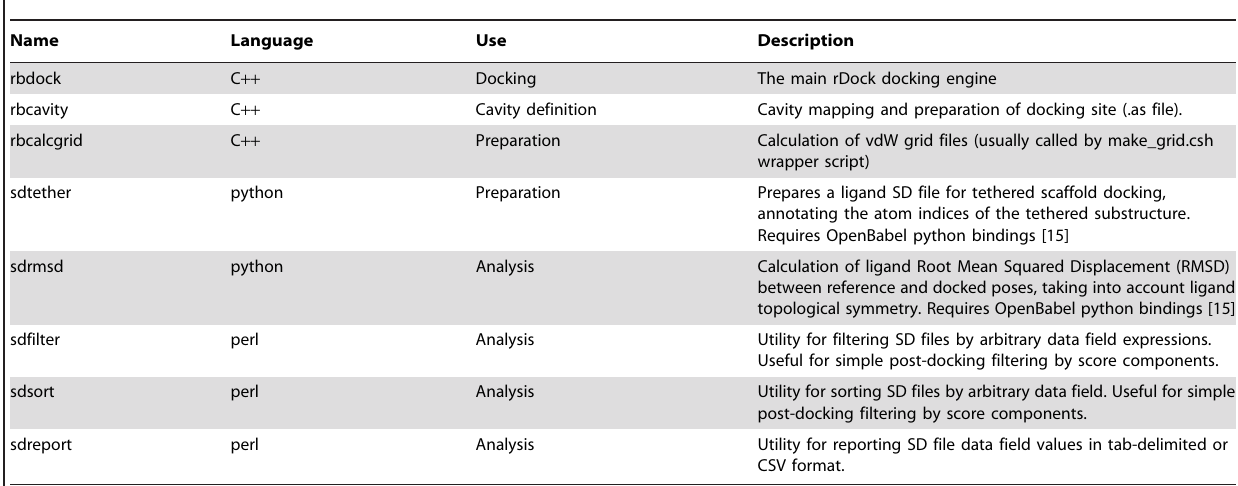
Table 1. List of main programs and utilities included in the rDock